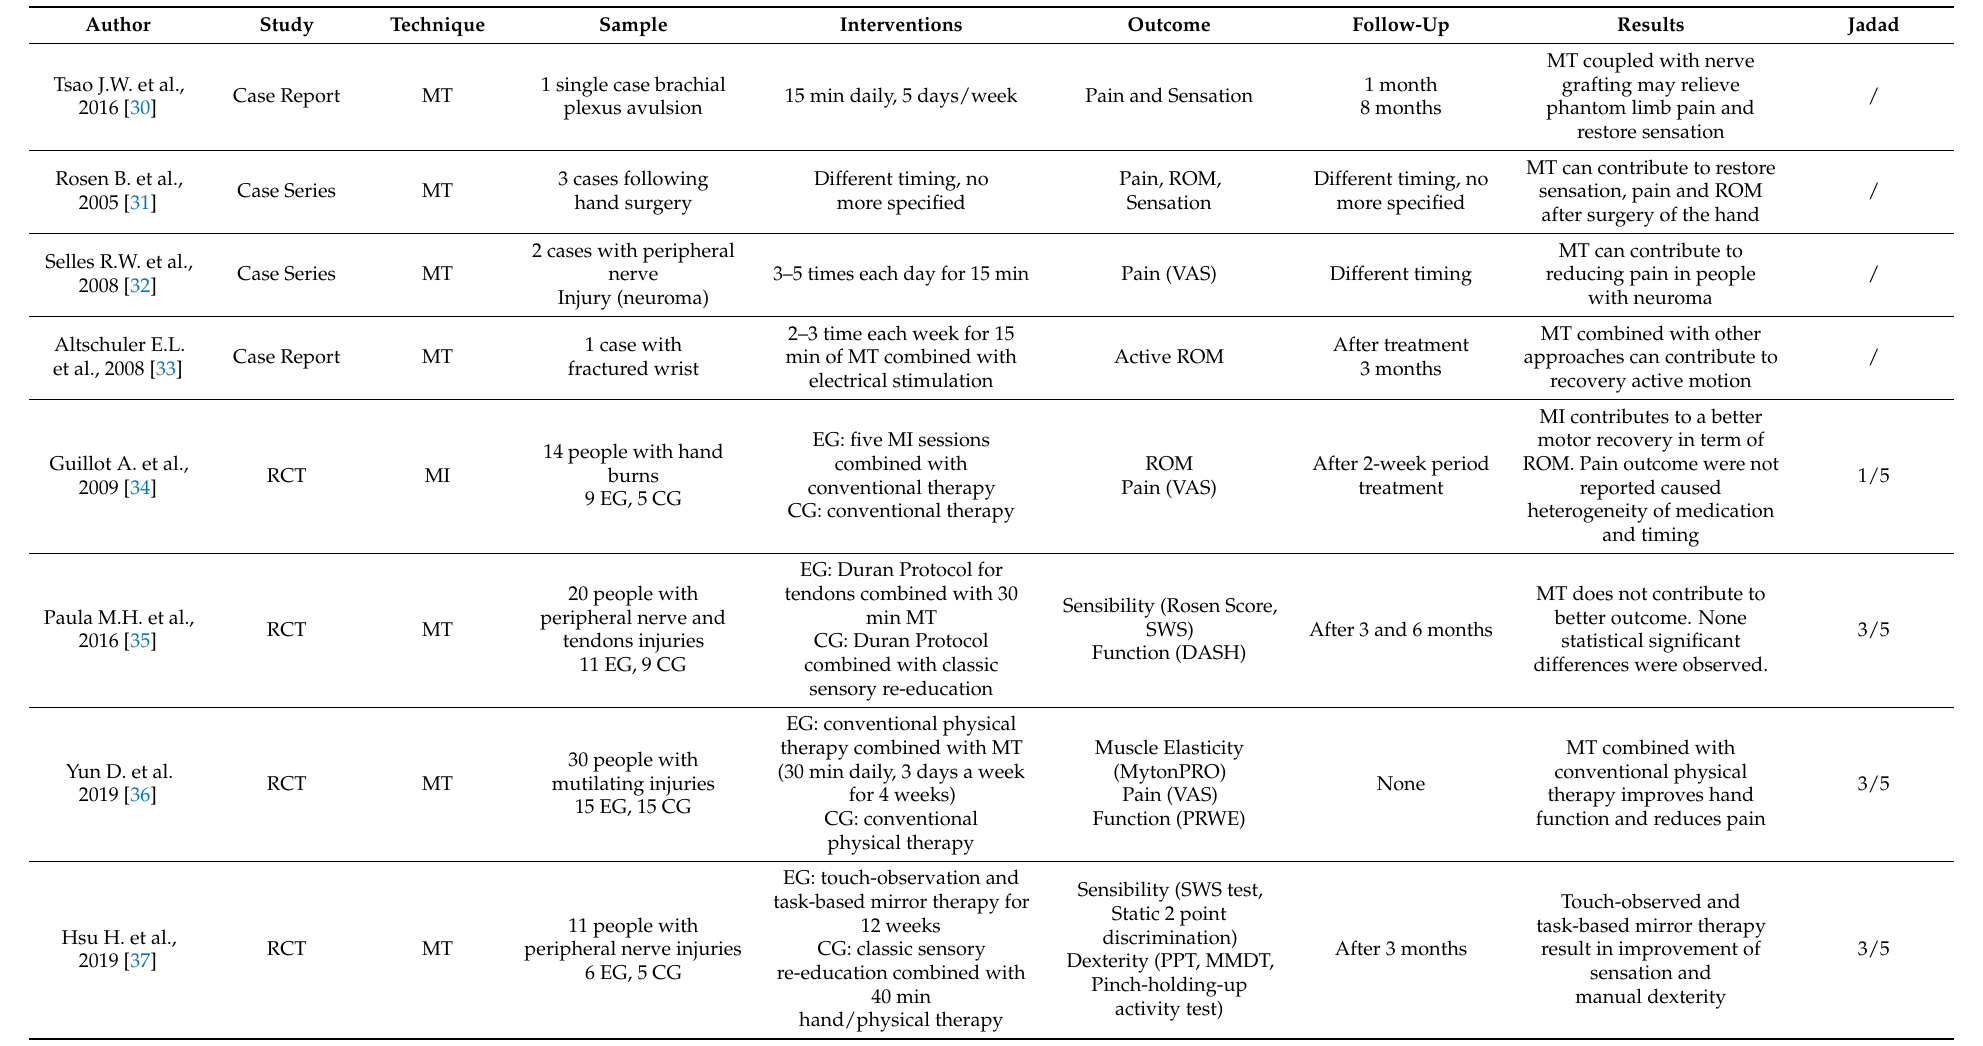
Table 1. Data Extraction of Selected